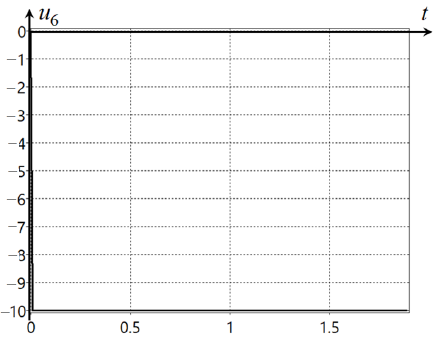
Figure A12. Plot of optimal values of control component u 6 .